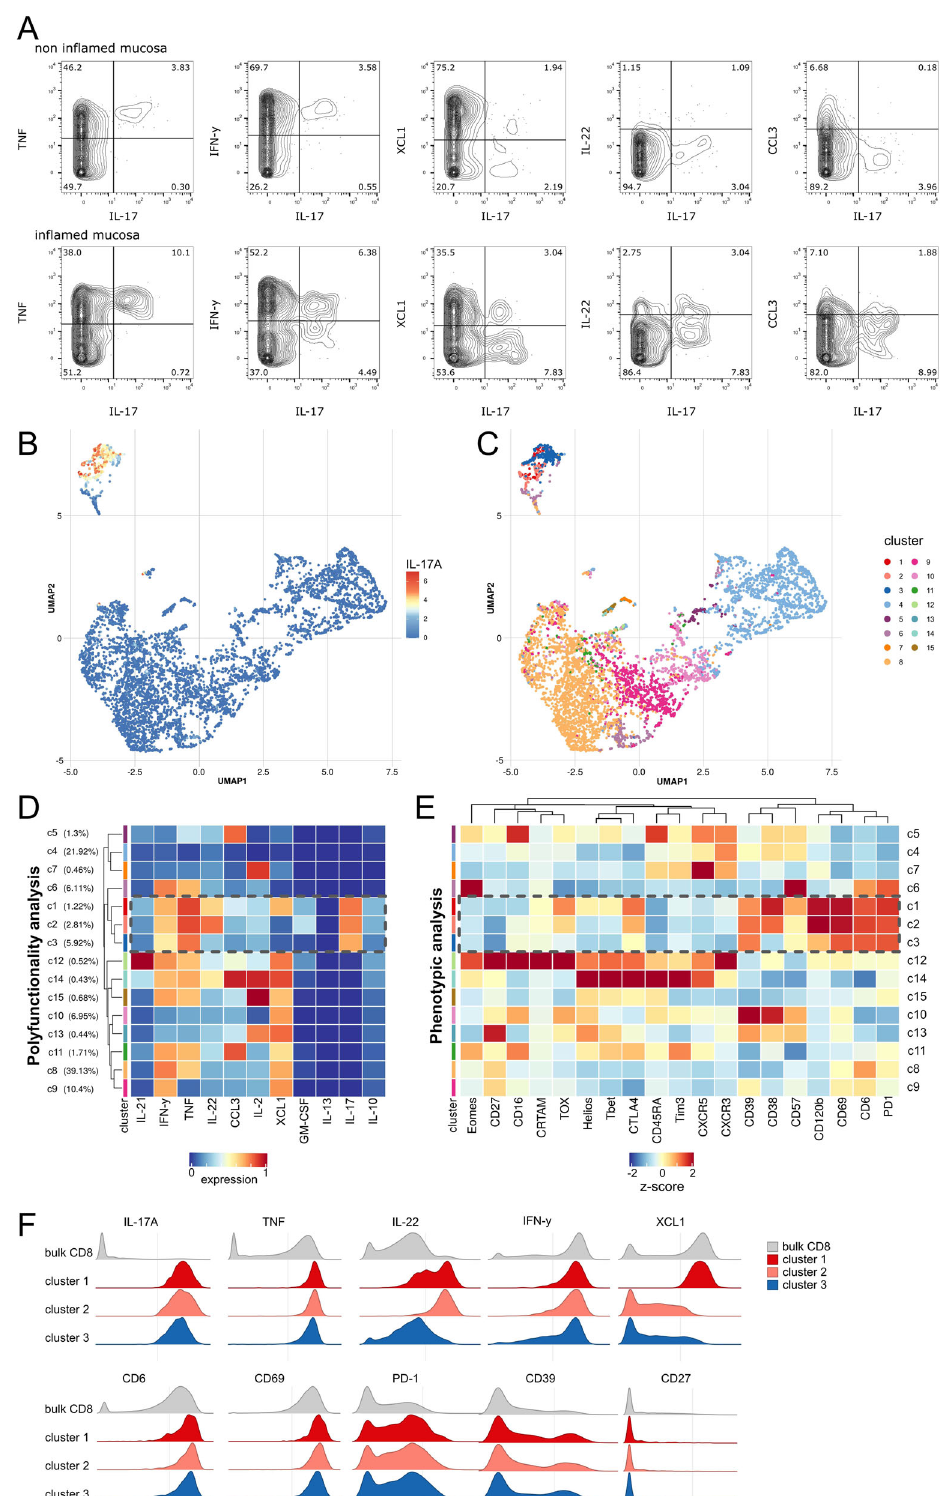
insights into the polyfunctionality expression patterns linked to Tc17 cells. UMAP analysis based on 11 cytokines/chemokines (IL-21, IFN- γ , TNF, IL-22, CCL3, IL-2, XCL1, GM-CSF, IL-13, IL-17 and IL-10) revealed Tc17 cells as a distinct population of cytokine-producing CD8 + T cells (Fig. 2B). FlowSOM clustering analysis further identi fi ed 15 T cell clusters with distinct poly- functionality patterns, of which three T cell clusters consisted of